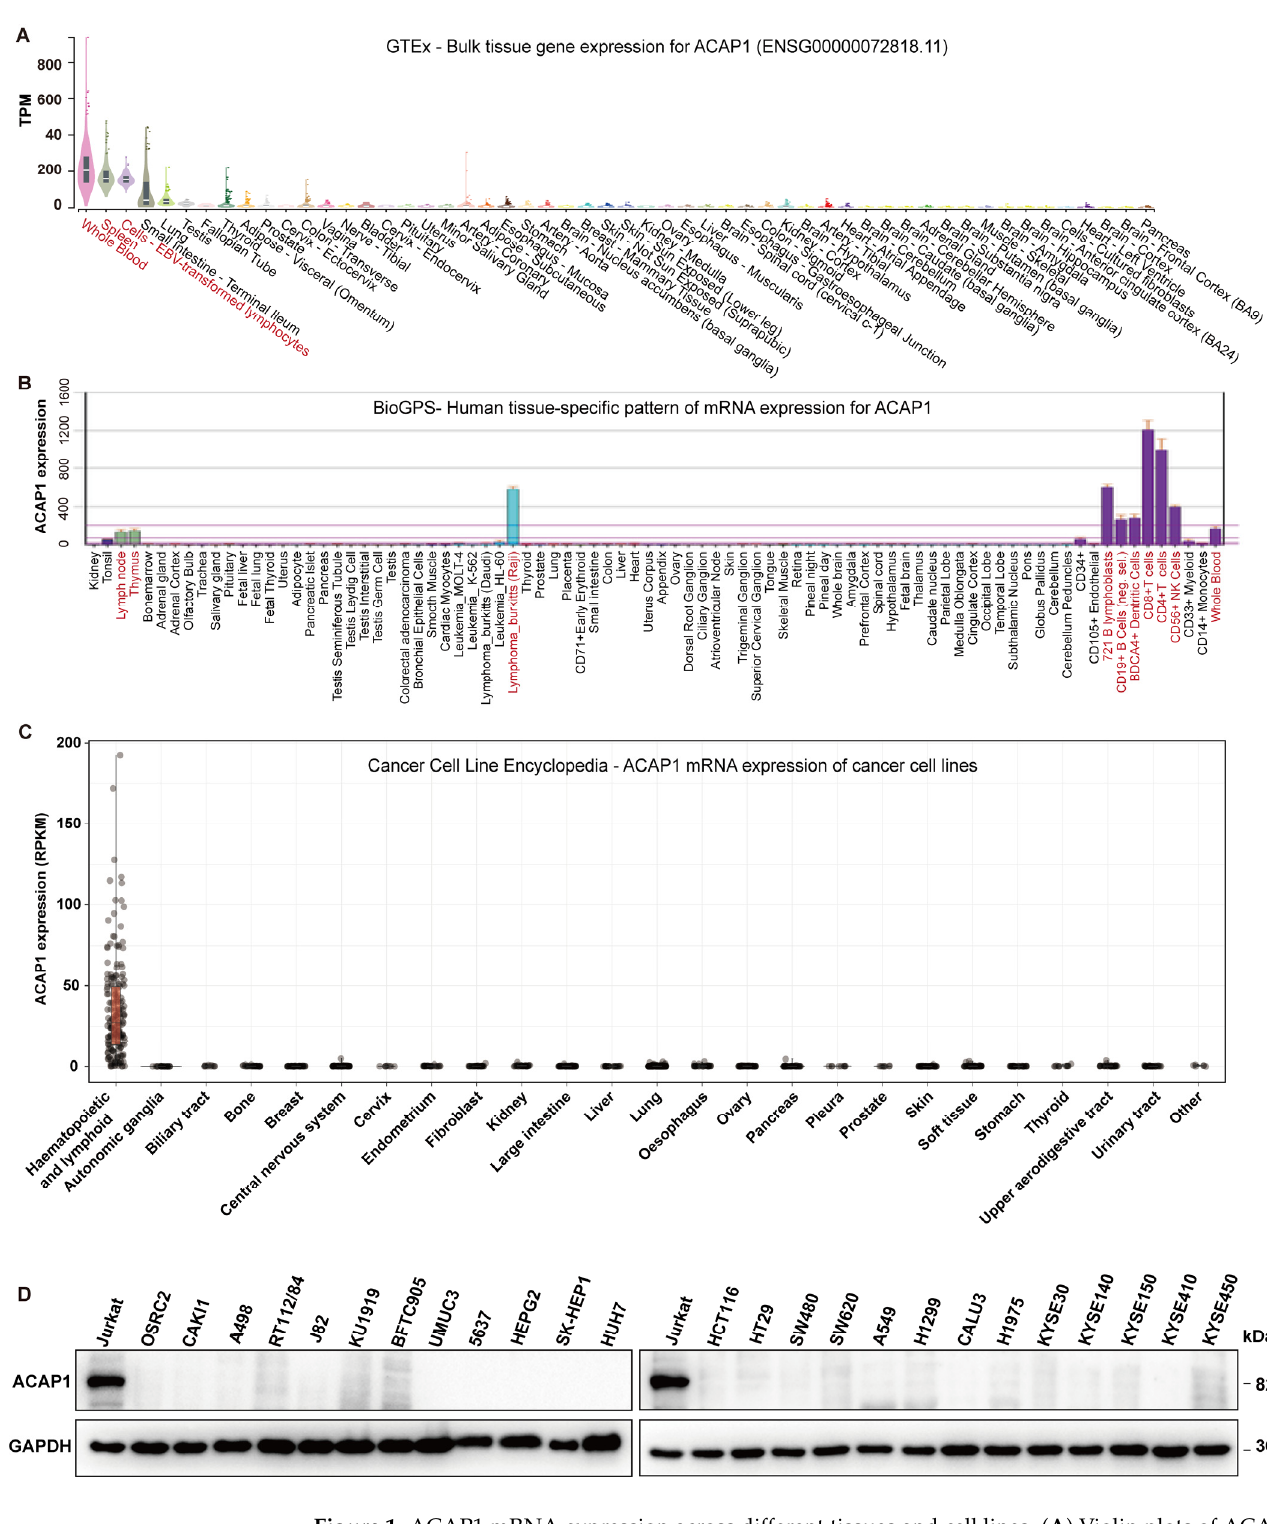
Figure 1. ACAP1 mRNA expression across different tissues and cell lines. ( A ) Violin plots of ACAP1 expression levels across all available tissues ordered by ACAP1 expression in the GTEx Portal. ( B ) ACAP1 expression levels in human tissues and cell lines were visualized by BioGPS. Red: tissues and cells with relatively high ACAP1 expression. ( C ) Violin plots of ACAP1 expres- sion levels across different types of cancer cell lines in the CCLE dataset. ( D ) The protein levels of ACAP1 from indicated cell lines were determined by Western blotting.